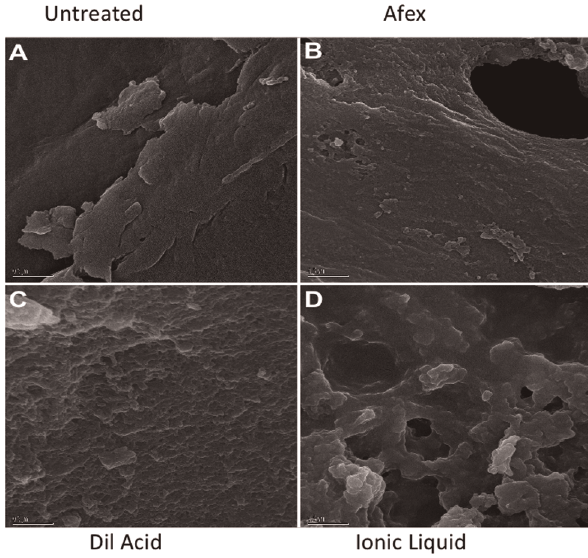
Figure 1. SEM images of untreated and pretreated switchgrass. A –untreated, B – AFEX-pretreated, C – dilute acid pretreated, D – ionic liquid pretreated.